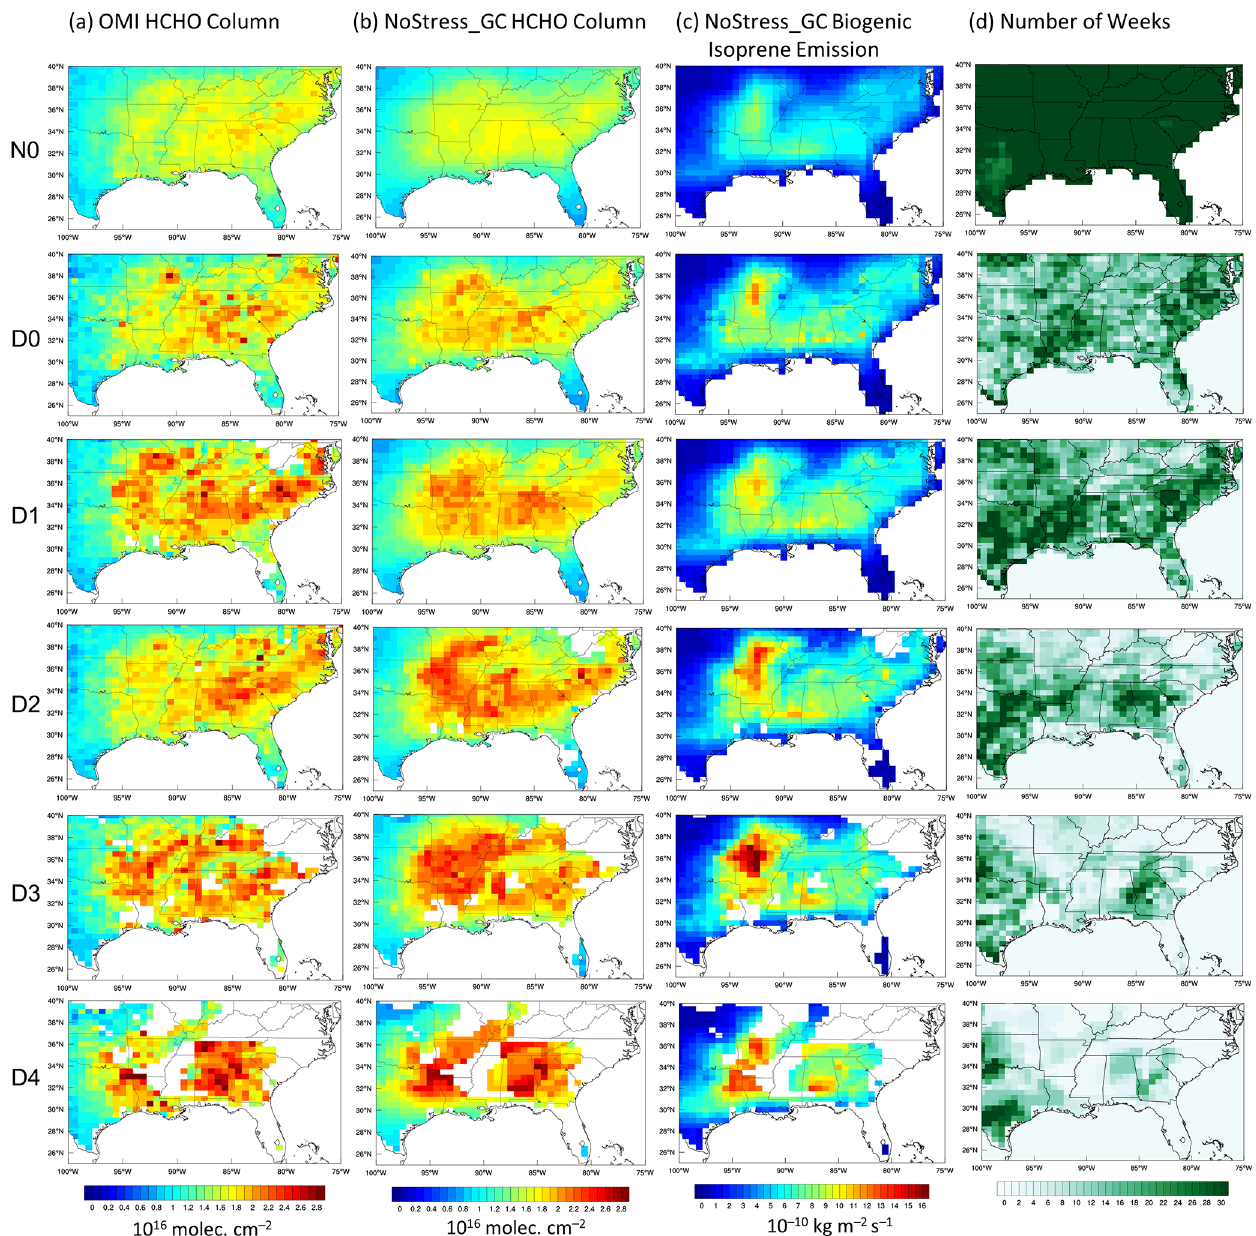
Figure 3. The mean spatial distributions of (a) OMI HCHO column density, (b) NoStress_GC HCHO column density, (c) NoStress_GC isoprene emissions, and (d) the number of weeks during JJA 2005–2017 in the SE US under different USDM drought levels (N0 and